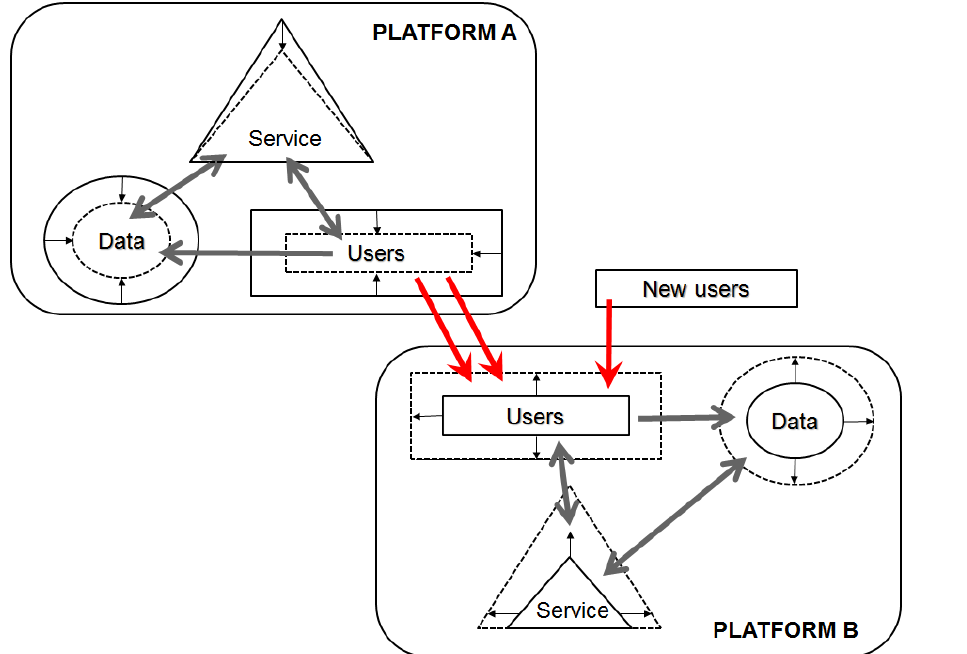
Figure 1: The Platform-Data Model for Substitutes. Solid lines show the initial situation. Dashed lines indicate the situation after platform B has gained market share. Thick arrows show dependencies. Qualitative